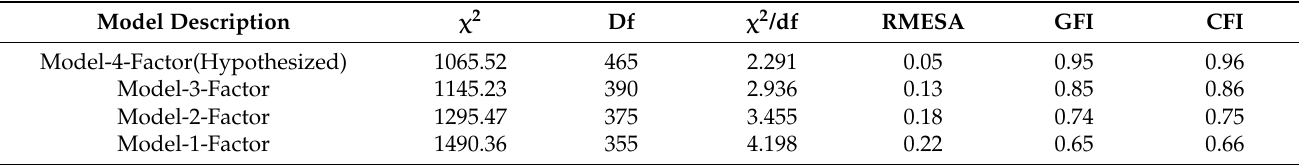
Table 2. Healthcare Institutionary Factor Analysis (CFA).